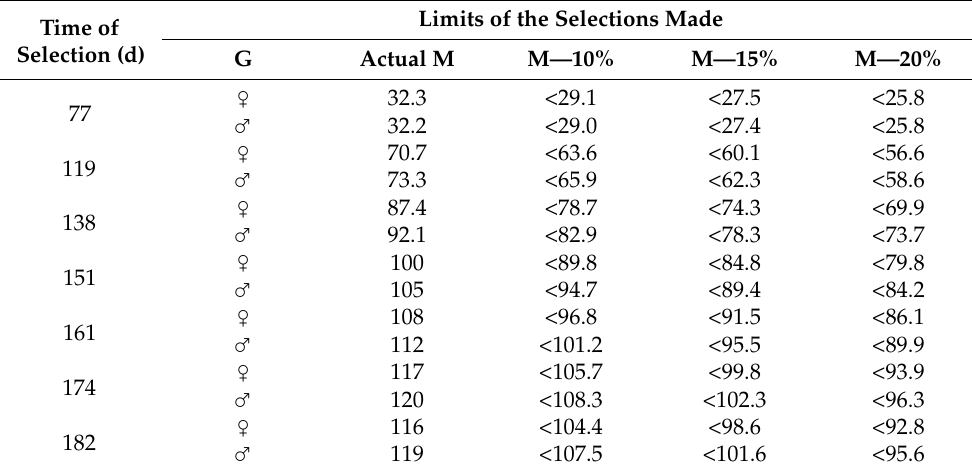
Table 7. Selection times and measures (kg) of the different selections based on body